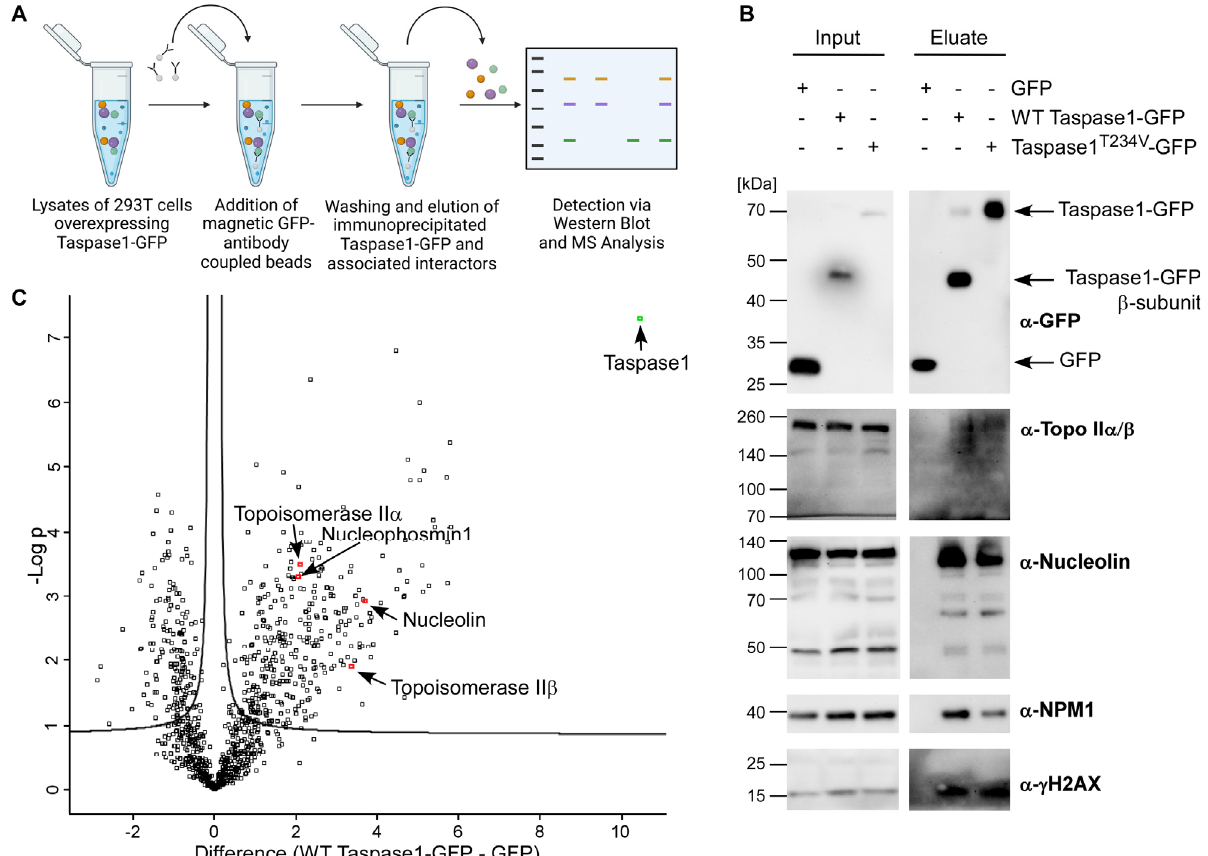
Figure 1. Taspase1 participates in the protein network that mediates estrogen-driven transcription. ( A ) Workflow of Taspase1-GFP co-immunoprecipitation (co-IP) followed by immunoblot analysis or mass spectrometry (MS). This illustration was created with BioRender.com. ( B ) Identification of novel Taspase1 interactors by co-IP combined with immunoblot analysis. ( C ) MS analysis of Taspase1-GFP co-immunoprecipitates. The enrichment of identified proteins in the Taspase1-GFP eluate (x-axis, intensity WT Taspase1-GFP–GFP) is plotted against the − log10-transformed p -values (y-axis), which is a measure for the reproducibility of the respective protein enrichment. The bait protein Taspase1-GFP is indicated in green. Further enriched proteins in the upper right section represent interactors of Taspase1. Topo II is among the most-enriched proteins in the Taspase1-GFP immunoprecipitates, as well as known interactors of Taspase1 such as NPM1.